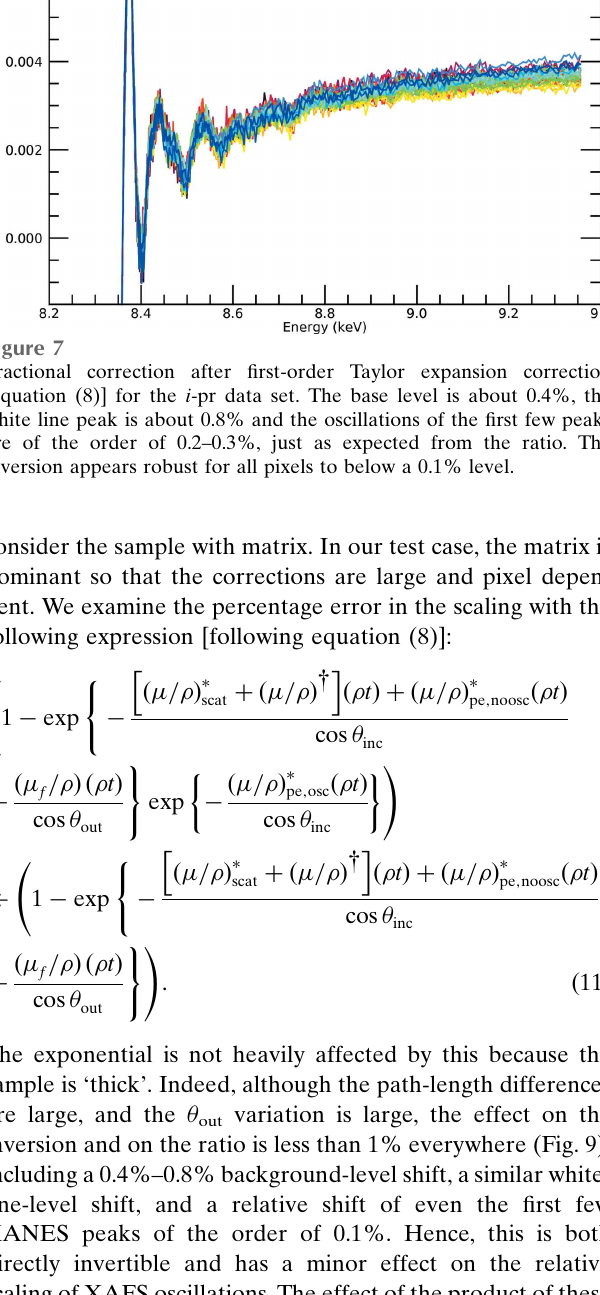
term on the exponential pe ; osc